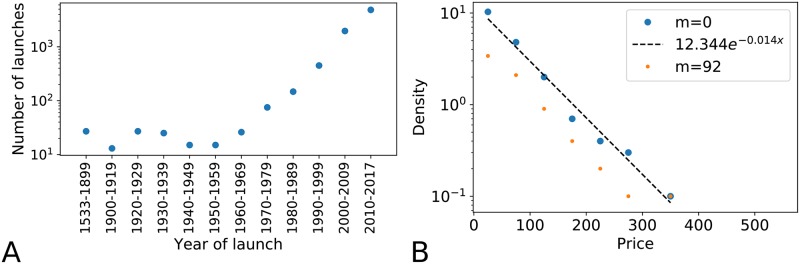
Relation between popularity measures, the number of reviews and the normalised average score W, and either perfume launch date or price in £ per 100ml.Panels A, B show that the majority of older perfumes (launched before 1970s) have a relatively large normalised average score W, whereas there is a much larger variation in scores acquired for perfumes launched more recently. Panels C and D show the relation between the two ratings and the price of perfumes. Perfumes that are of low price have a generally smaller number of reviews (the bell of a violin plot is concentrated close to 0) as opposed to more expensive perfumes, say those costing more than £150/100ml or more. However, several perfumes that are cheap have a very large number of reviews. Panel D shows that the intervals of cheaper perfumes (price smaller that £100/100ml) seem to be composed of a larger variety of perfumes: some with high score and some with low, whereas the more expensive perfumes have consistently high scores. Despite some differences in the spreads and distributions of W and V for perfumes in different age and price brackets, the figures do not reveal any strong correlation between the age or price of a perfume and its success.